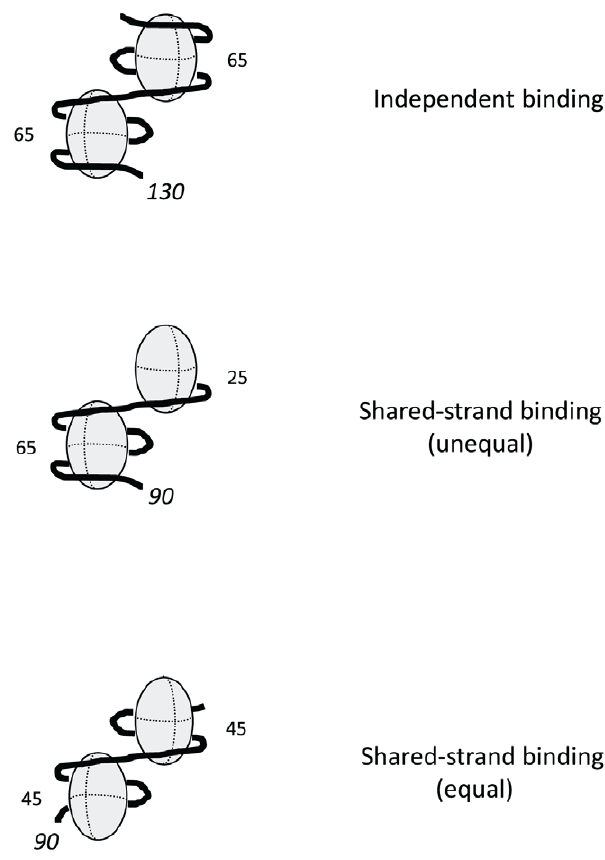
Figure 10. Independent and shared-strand DNA binding complexes. The first complex represents an independent binding complex in which two SSB tetramers are each bound to a 65-nucleotide segment of a dT 130 molecule. The second complex represents a shared- strand binding complex in which one SSB tetramer is bound to a 65- nucleotide segment and the second SSB tetramer is bound to the remaining 25-nucleotide segment of a dT 90 molecule ( unequal sharing ). The third complex represents a shared-strand binding complex in which two SSB tetramers are each bound to a 45-nucleotide segment of a dT 90 molecule ( equal sharing ). The paths shown for the dT n strands in these complexes are speculative and are based on a structural model of the SsbEc protein bound to single-stranded DNA in the SSB 65 binding